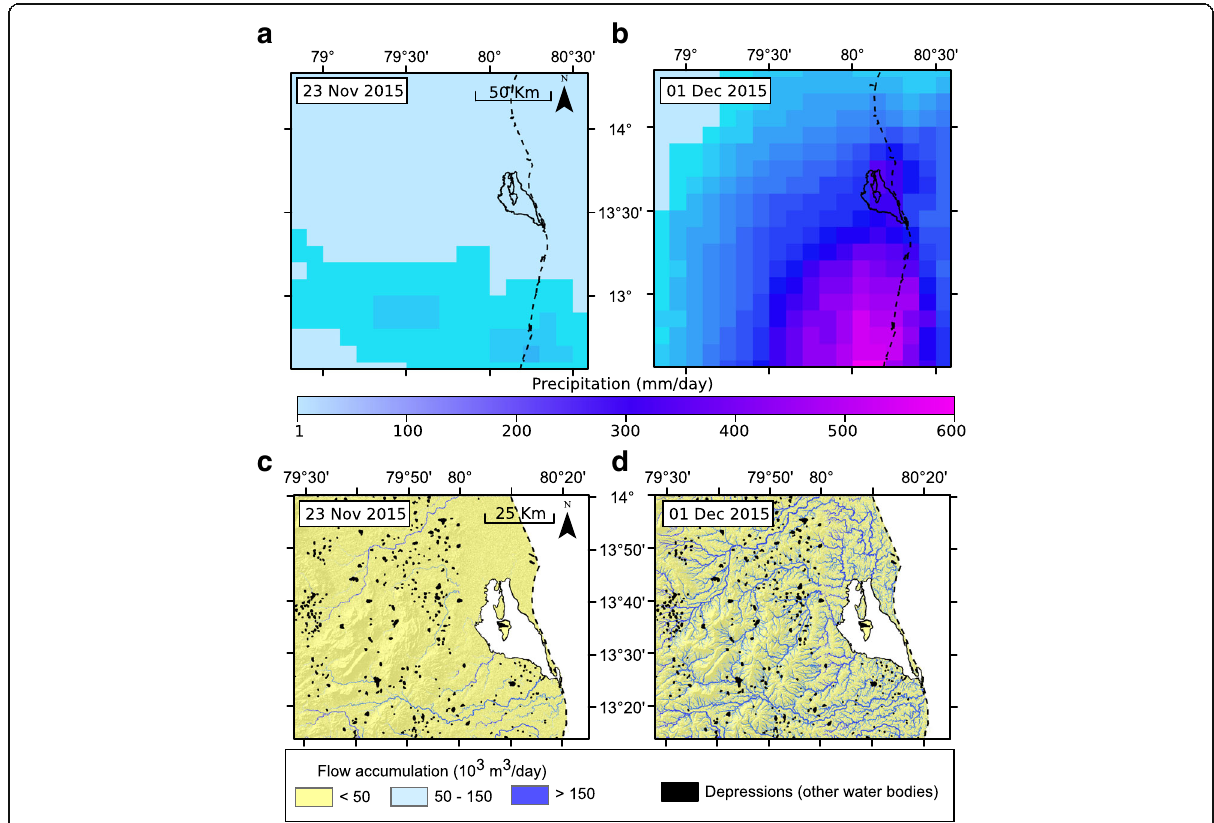
Fig. 2 Example scenarios of precipitation ( a and b ) and the modelled flow accumulation ( c and d ) over Pulicat watershed are shown for 2 days representing a typical monsoon day (November 23, 2015) and the day of peak rainfall (December 1, 2015)